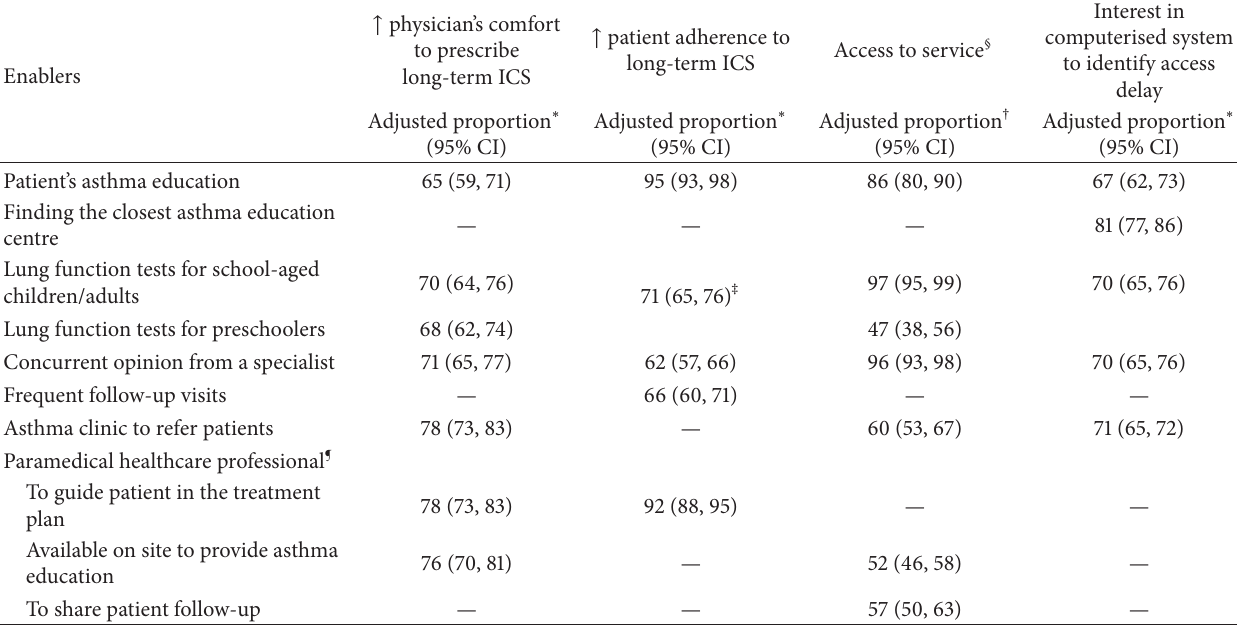
Table 3: Resources that support physician’s prescription of, and patient’s compliance to, long-term inhaled corticosteroids (ICS).